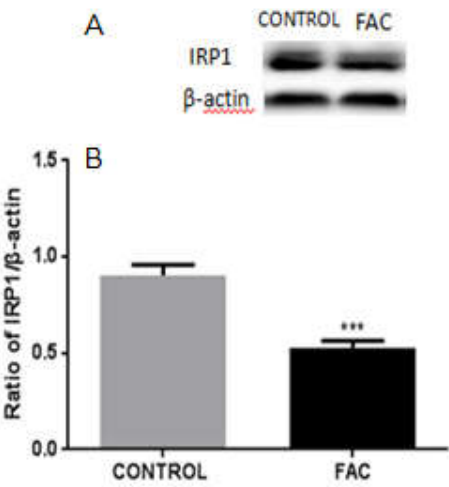
Figure 7. The protein levels of IRP1 in FAC-treated BV2 cells. ( A ) Western blot analysis of IRP1 protein levels. IRP1 levels were decreased in 100 µ M of FAC-treated BV2 cells compared to those of mock-treated cells. β -actin was used as the loading control. ( B ) Data are presented as the ratio of IRP1 to β -actin levels. Each bar represents the mean ± SEM from six independent experiments. n = 6. *** p < 0.001, compared with the control group.